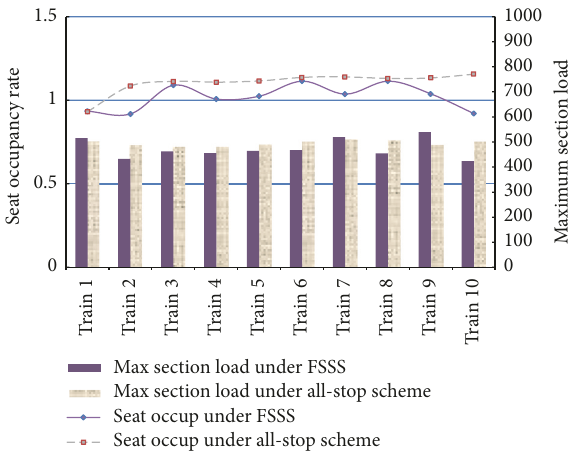
Figure 9: Seat occupancy and onboard passengers per